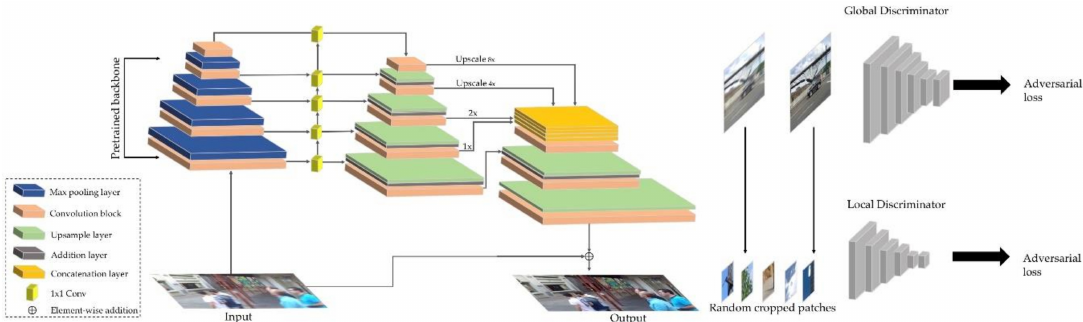
Figure 1. Deblur method generative adversarial network (GAN) architecture [64]. Reproduced under consent of the